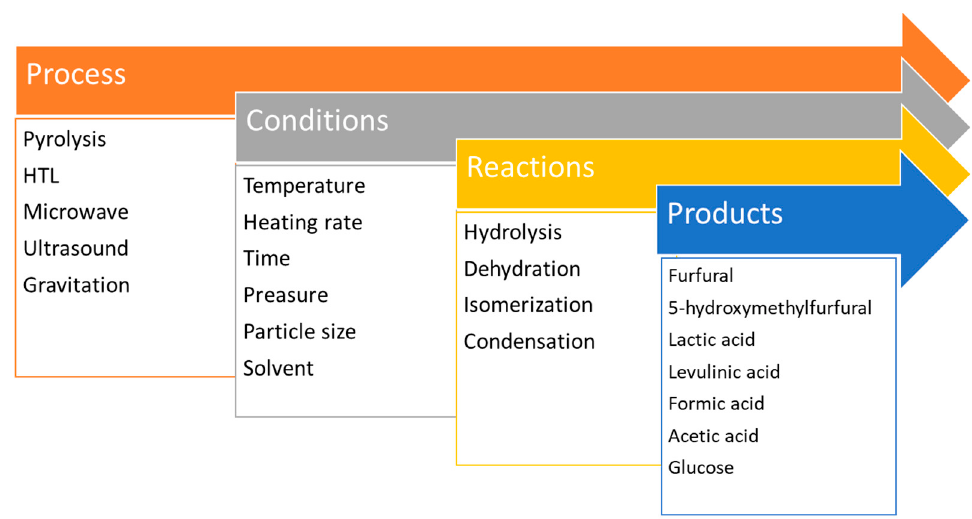
Figure 1. Schematic representation of biomass/cellulose